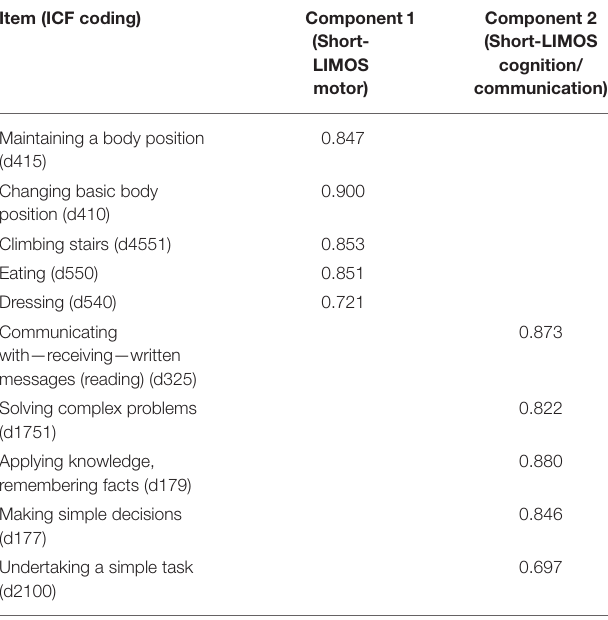
TABLE 2 | Principal component analysis of the